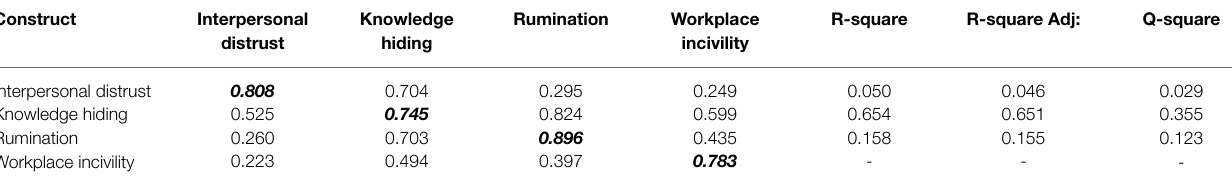
R-square R-square Adj: Q-square